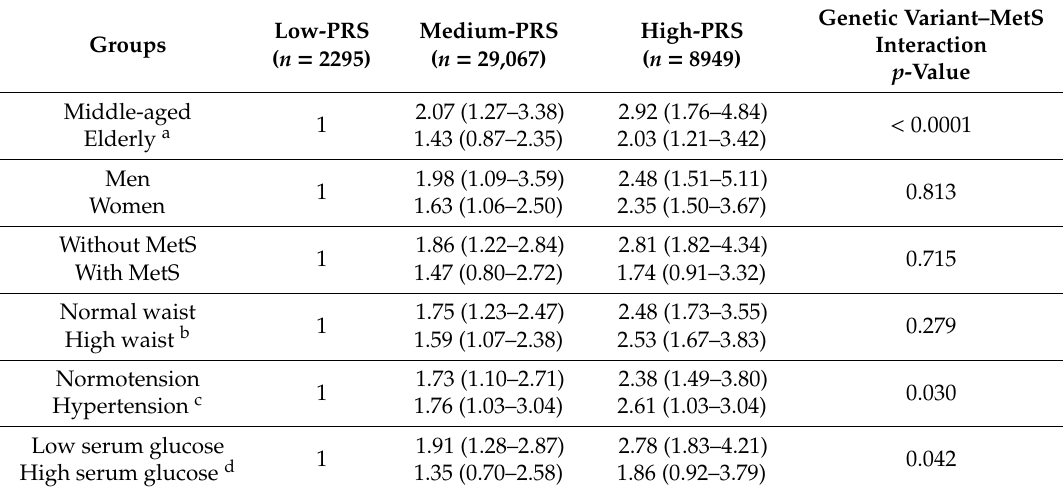
Table 4. Adjusted odds ratios for the age-related cataract risk by polygenetic risk scores of the best model (PRS) in the gene–metabolic syndrome after covariate